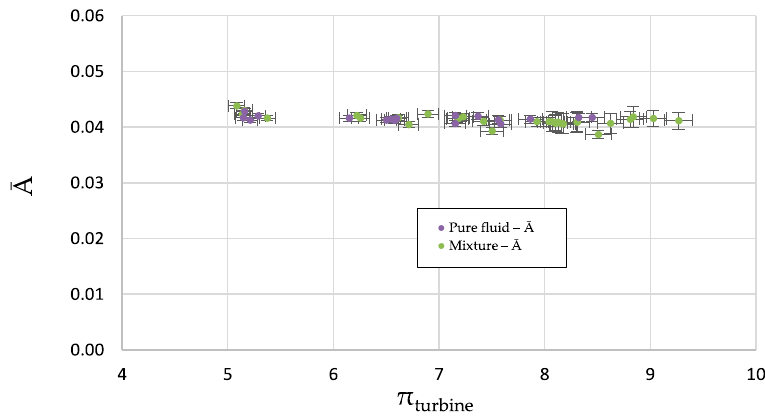
Figure 3. The turbine’s dimensionless parameter according to the pressure ratio. 320